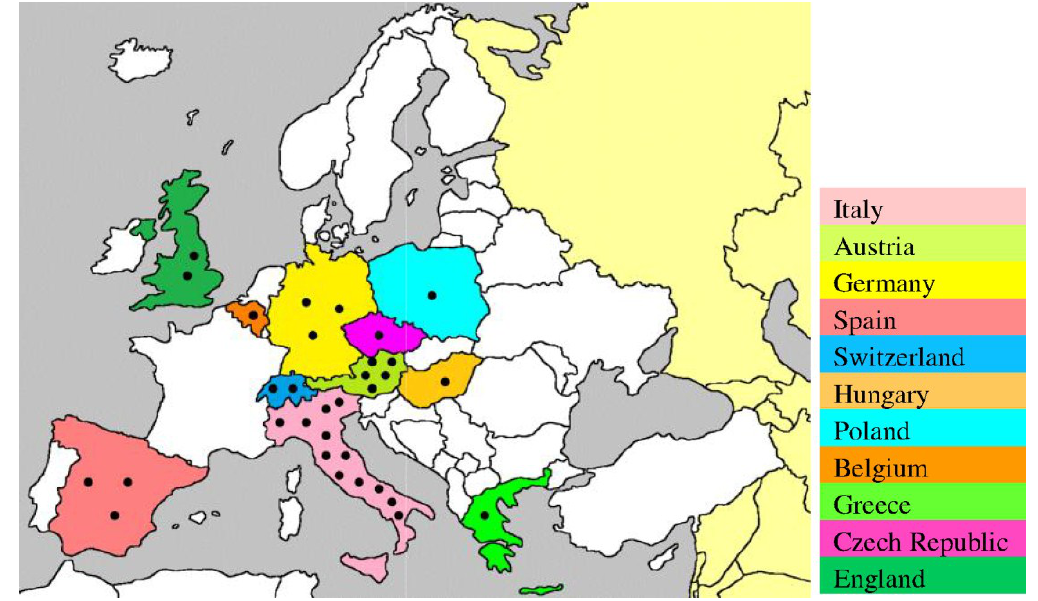
Figure 1. Geographic locations of USUV-related epidemiological studies on birds and mosquitoes in Europe. These studies were conducted using immunohistochemistry, reverse transcription-PCR, indirect immunofluorescence assay, ELISA, and plaque reduction neutralization assay [10,11,25,29–33,38–44]. Each epidemiological study is indicated by